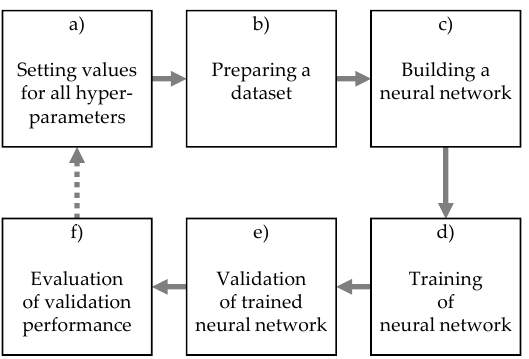
Figure 3. Procedure within a single hyper-parameter optimization step.